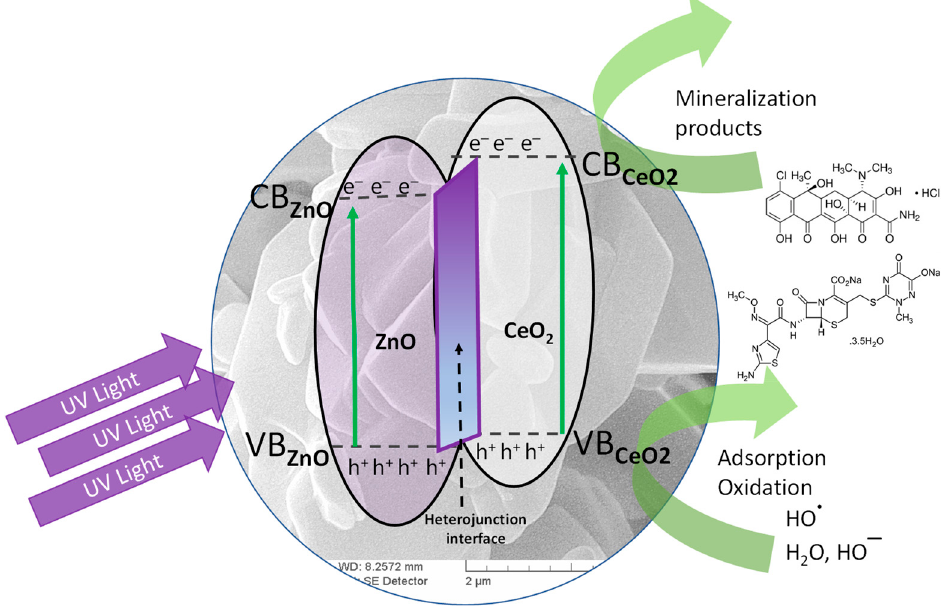
Figure 8. Proposed reaction mechanism for the photocatalytic activity of CeO 2 /ZnO heterojunctions.